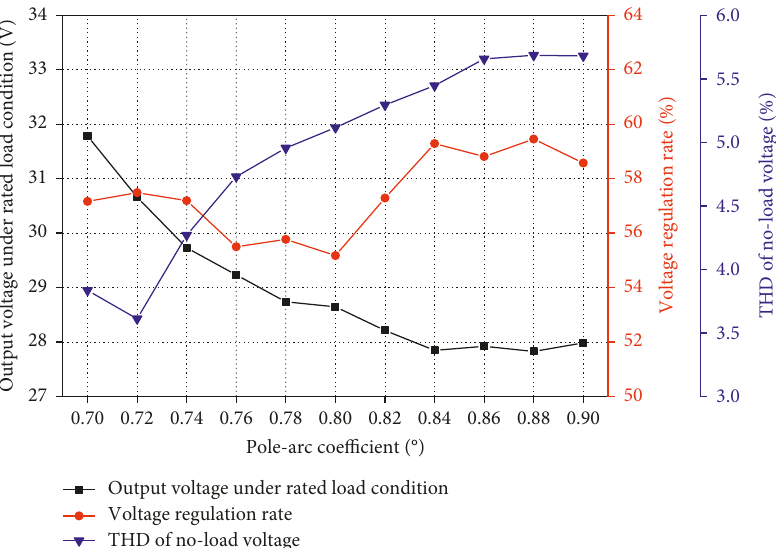
Figure 19: Variation curves of generator output performance with different pole-arc